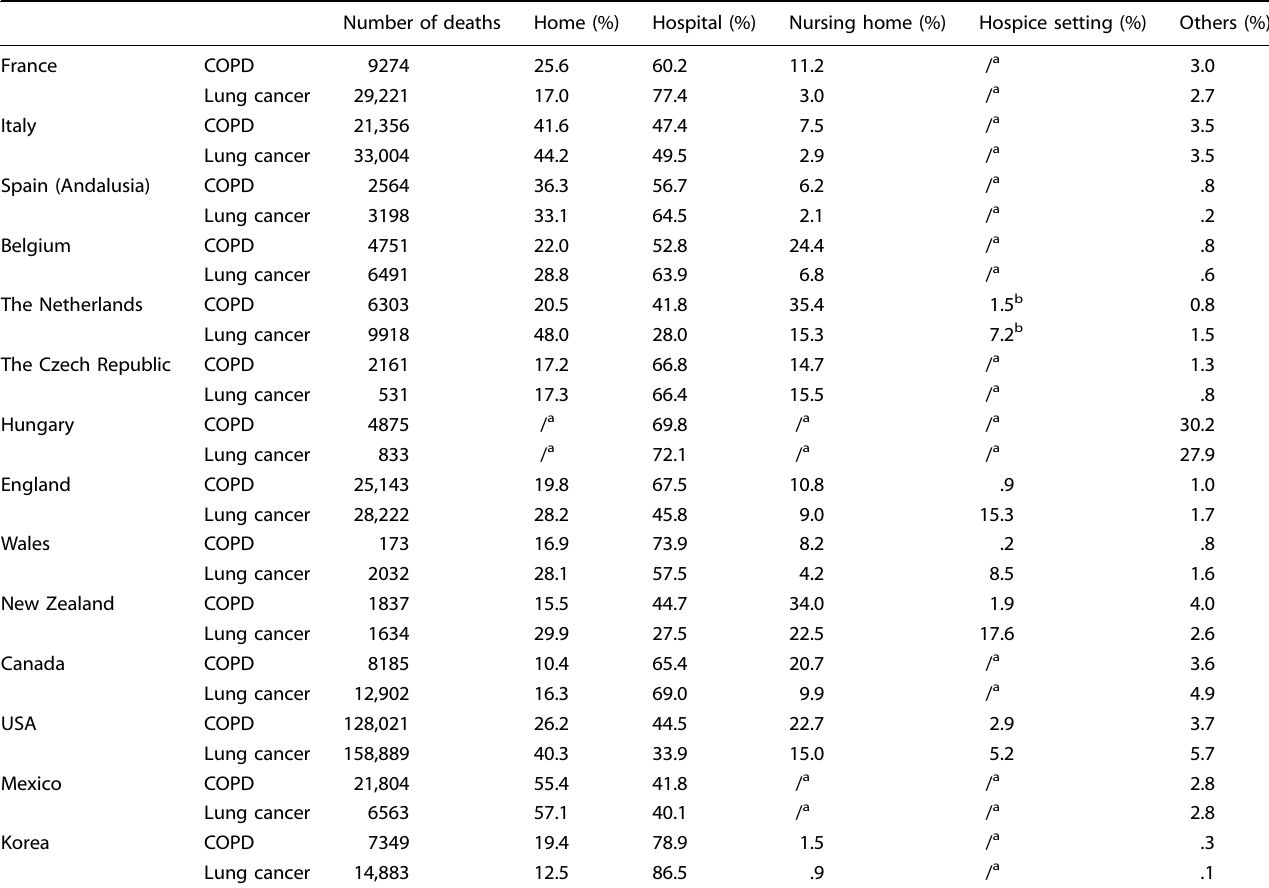
Table 3. The place of death of deceased patients with COPD and lung cancer by country ( N =